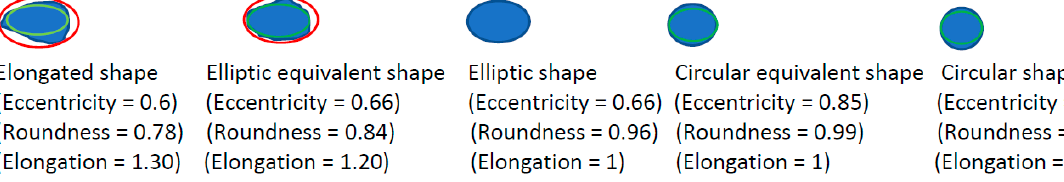
Figure 11. Examples of descriptor values for various patterns. The elliptic bounding box corresponds to the red ellipse. The inscription corresponds to the green ellipse.